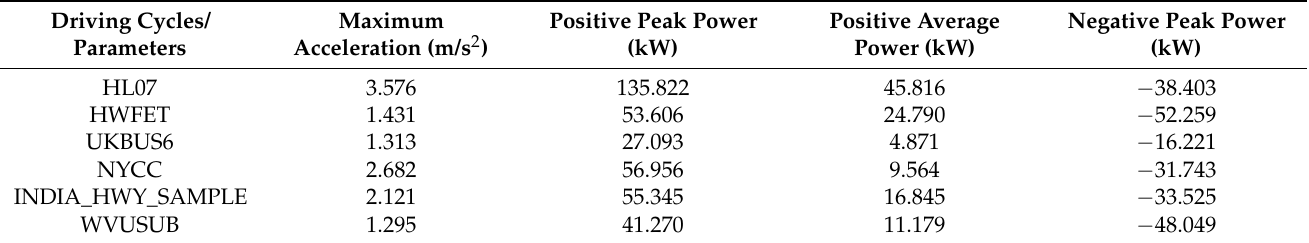
Table 2. Different driving cycles’ power demand